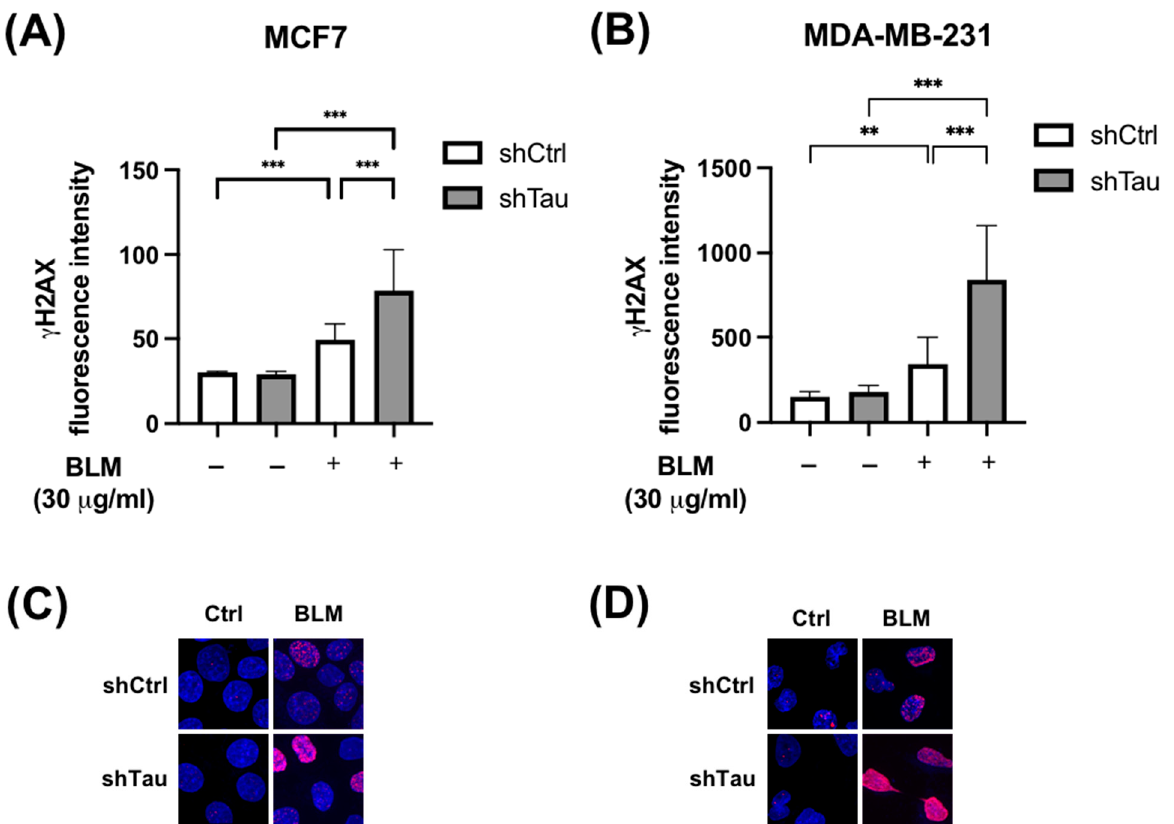
Figure 1. Inhibition of Tau increases γ -H2AX levels after bleomycin treatment in MCF7 and MDA- MB-231. ( A ) MCF7 and ( B ) MDA-MB-231 shCtrl or shTau stable clones were or were not treated with bleomycin (30 μ g/mL) for 2 h. Cells were then labeled with a γ -H2AX antibody to quantify DNA double-strand breaks. Nuclear γ -H2AX bulk fluorescence intensity was analyzed using Image J. All experiments were carried out in three independent experiments. Data are mean ± SD (n > 60 cells per conditions) ** p < 0.01; *** p < 0.001. Representative images of γ -H2AX (red) staining in ( C ) MCF7 and ( D ) MDA-MB-231 shCtrl or shTau stable clones treated or not with bleomycin (30 µ g/mL) for 2 h. DAPI nuclear counterstaining is shown in